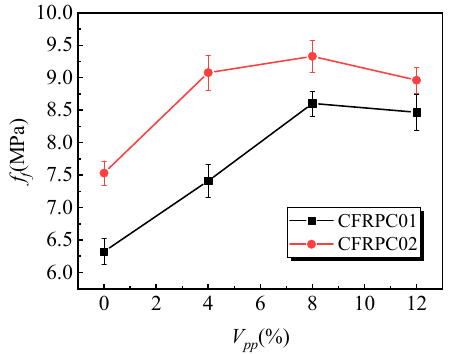
Figure 6. Effect of the polymer–cement ratio on the flexural strength of the specimens.